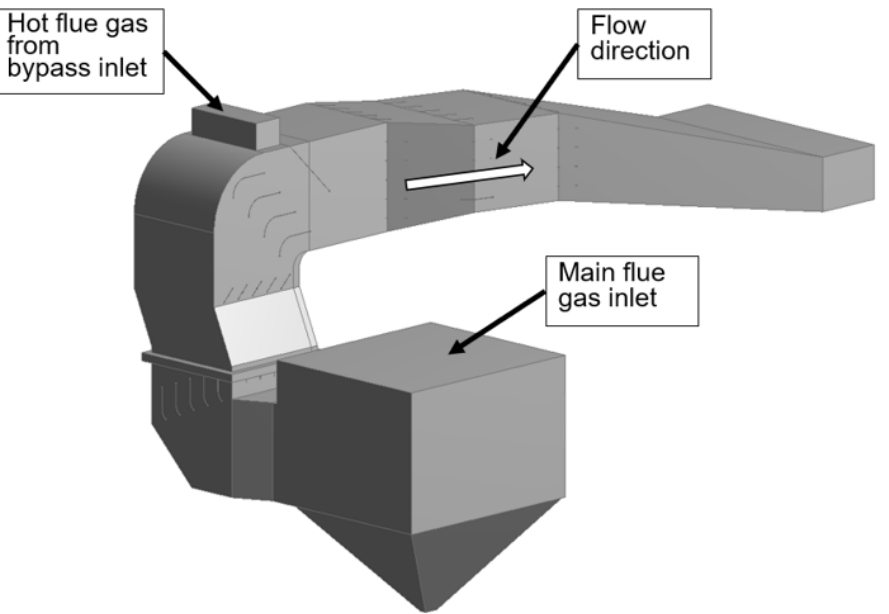
Figure 2. A general schematic of the examined flue gas duct section.